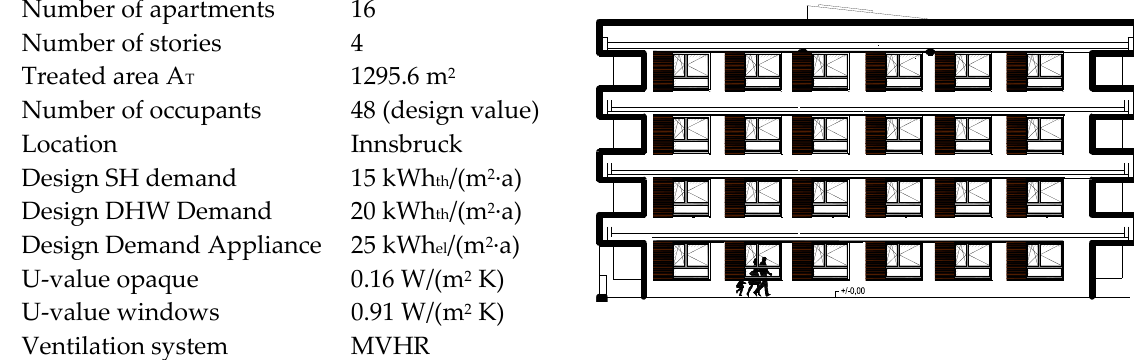
Table 3. Quality of the building envelope and type of ventilation system for the different building energy standards with extract air or mechanical ventilation with heat recovery (MVHR).